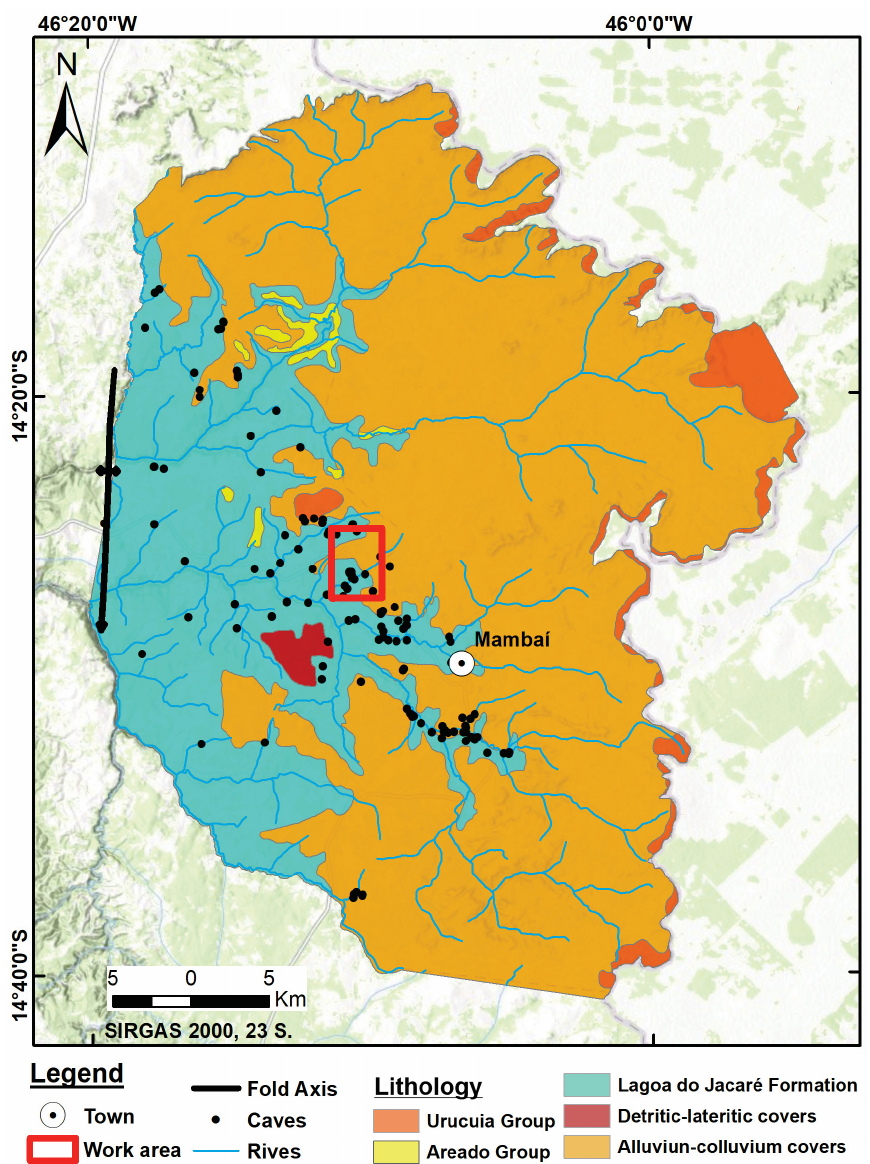
Figure 2. Geological map of the environmentally sensitive area of the River Vermelho showing different geological units, surface hydrology and the presences of mapped caves (black dots).